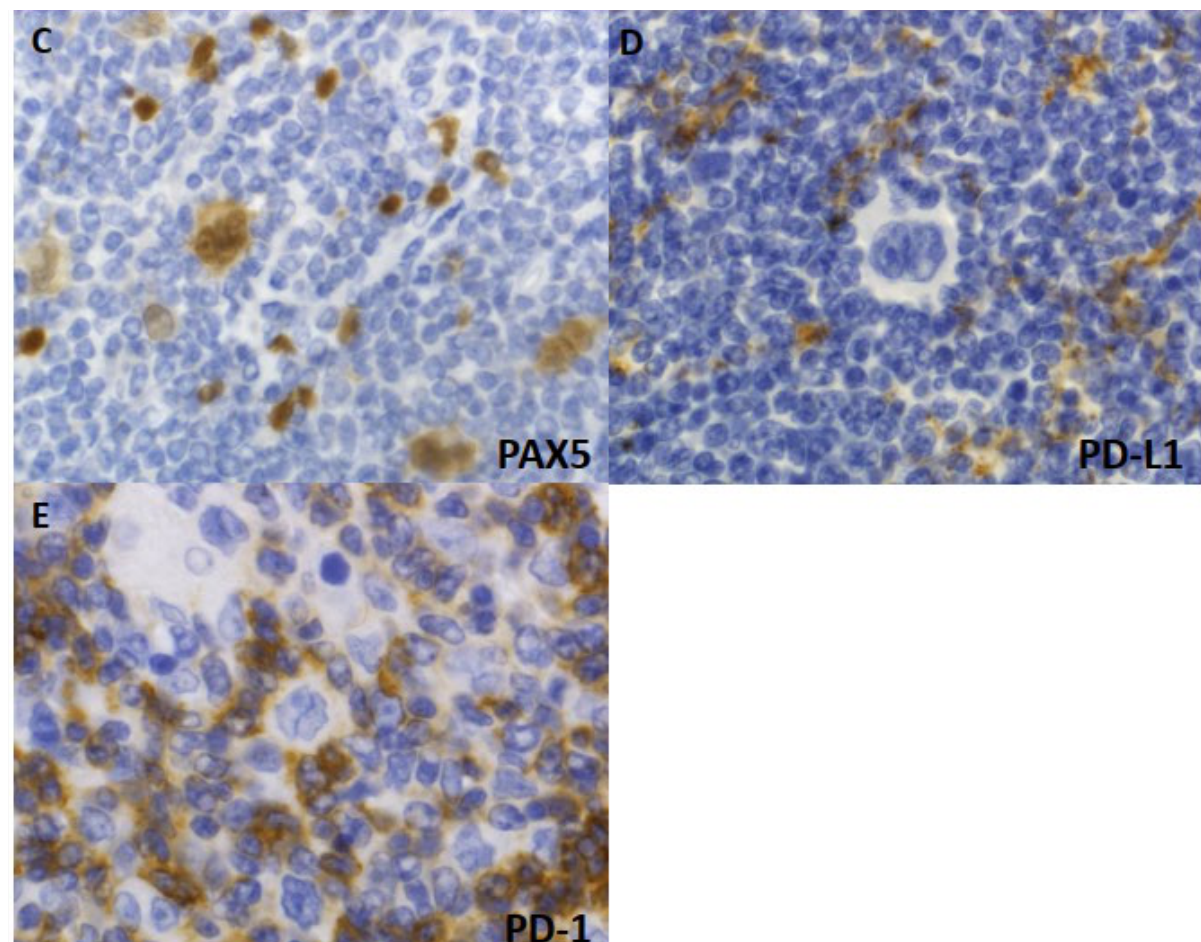
Figure 3. Histological and immunohistochemical features of nodular lymphocyte-predominant HL (NLPHL). ( A ) Vague nodular architecture is observed. ( B ) Scattered neoplastic cells feature polylobated (popcorn-like) nuclei, and are called lymphocyte-predominant (LP) cells. ( C ) LP cells show strong PAX5 expression. ( D ) LP cells lack PD-L1 expression (assessed using clone SP142). ( E ) LP cells are ringed by PD-1-positive “rosetting” T lymphocytes.